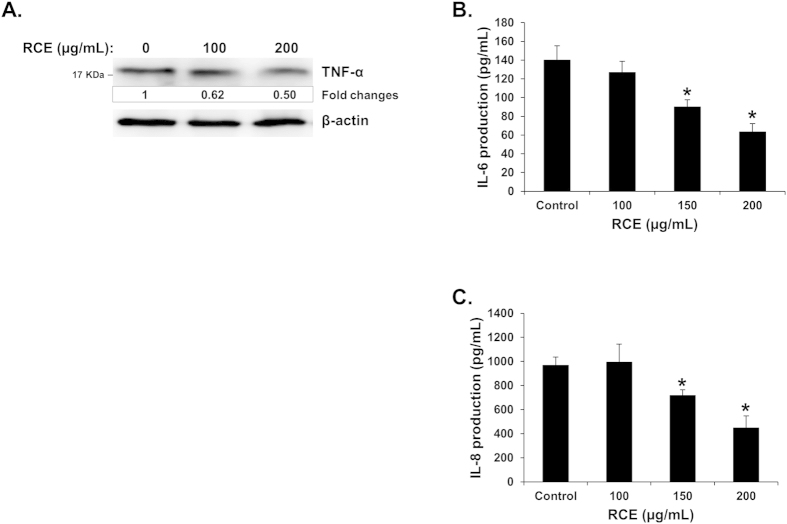
Effects of Rhus coriaria on the expression of TNF-α, IL-6 and IL-8 cytokines in MDA-MB-231 cells.(A) Western blot quantification of TNF-α protein in RCE-treated MDA-MB-231 cells. MDA-MB-231 cells were treated with vehicle (0.2% ethanol) or indicated concentrations of RCE for 24 h, and then whole-cell extracts were subjected to Western blot analysis for TNF-α and β-actin proteins. Each lane was loaded with 25 μg of whole cell extracts. Loading was normalized to the levels of β-actin. The intensities of the bands were quantified using the ImageJ software (National Institute of Health, USA). (B,C) Reduction of IL-6 (B) and IL-8 (C) production in MDA-MB-231 cells. IL-6 and IL-8 production was quantified by ELISA as described in Materials and Methods. Data represents means ± SEM of three independent experiments. Statistical analysis was performed using one-way ANOVA (*p < 0.05, **p < 0.005).